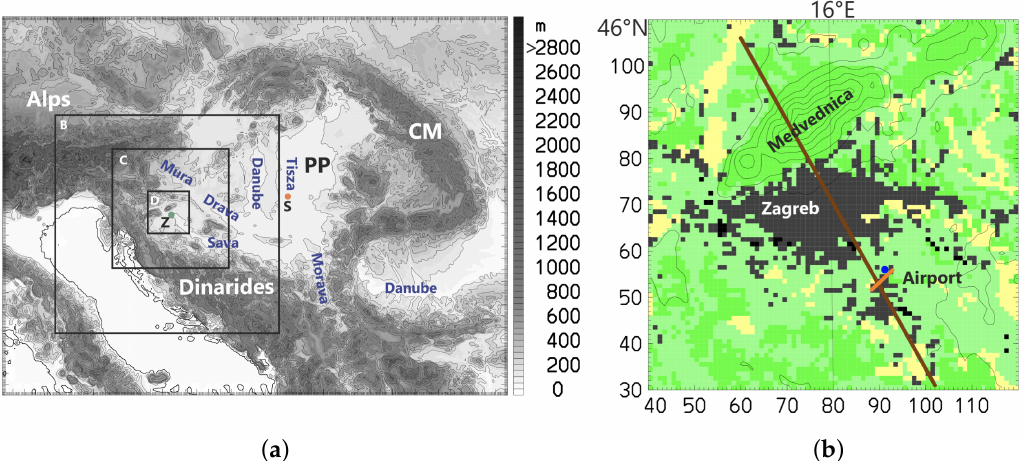
Figure 1. ( a ) The Pannonian Basin with indication of the 3 inner embedded domains of the WRF-ARW simulation, with the main topographical features (PP: Pannonian Plain, CM: Carpathian Mountains), some river names in blue, and Zagreb (Z) and Szeged (S). ( b ) The Zagreb Airport area, with the city to the NNW and the Medvednica mountain range to the NW–NNE. The orange bar indicates the runway of the airport and the blue circle the location of the